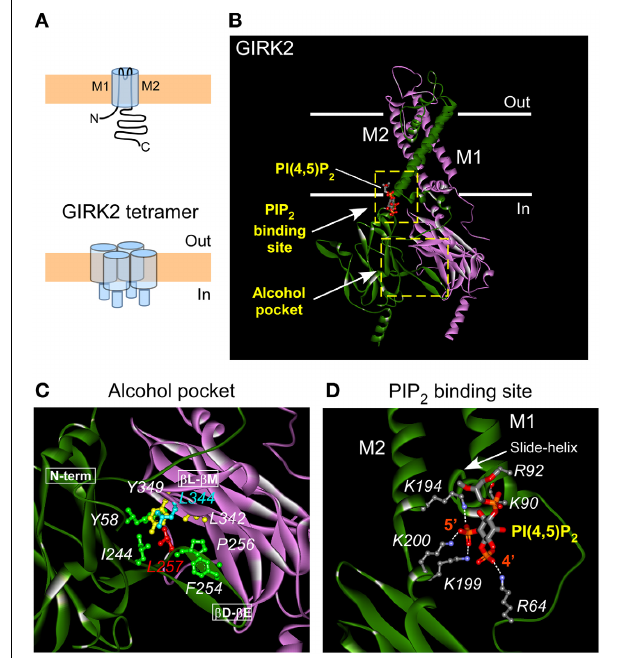
FIGURE 1 | Structural views of alcohol and PIP2 pockets in GIRK2. (A) Schematic of GIRK channel monomer (above) and tetramer (below) depicting the N and C terminal regions, and the M1, M2 transmembrane domains. (B) Crystal structure (3SYA) of GIRK2 channel (3.6Å resolution; two of four subunits shown; adapted from Whorton and MacKinnon, 2011) bound to PI(4,5)P 2 /PIP 2 (indicated by the arrow). The PIP 2 binding site is located at the interface between transmembrane and cytosolic domains of GIRK channel. Solid white lines indicate the approximate boundary of the membrane lipid bilayer. (C) Enlarged view of the alcohol pocket in GIRK2 channel formed by part of N-terminal domain, β D- β E and β L- β M loops from two adjacent subunits (Aryal et al., 2009). Amino acids lining the alcohol pocket are indicated, plus critical G βγ site L344 on the GIRK2 crystal structure (4KFM, Whorton and MacKinnon, 2013). For a view of alcohol bound to the closely related Kir2.1 channel see Aryal et al., 2009. (D) Enlarged view of the PIP 2 binding site reveals key residues (shown in ball and stick model) involved in binding PIP 2 and stabilizing the channel’s open state. Also indicated are the major points of electrostatic coordination (white dashed line) between the 4 (cid:2) and 5 (cid:2) phosphate of PIP 2 molecule and critical residues (R64, K194, K199, K200) in GIRK2 channel